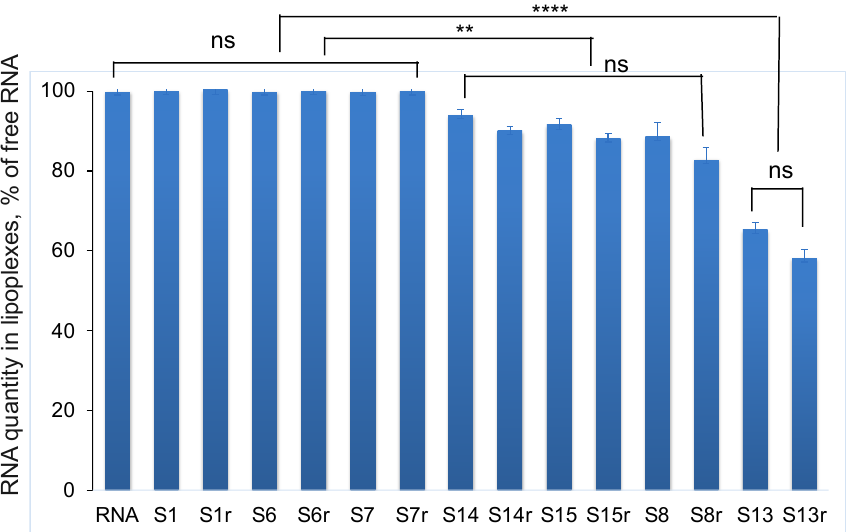
Figure 4. Quantity of RNA (relative to free RNA control, %) calculated from the average fluorescence intensity of SYBR Green I during the incubation of lipoplex samples for 30 min. Incubation of samples with RNase (index r) and without enzyme (no index); all samples were prepared in water. See Table 1 for LNP composition, mean ± SE. **, A statistically significant difference, p < 0.001; ****, a statistically significant difference, p < 0.0001; ns, not significant.